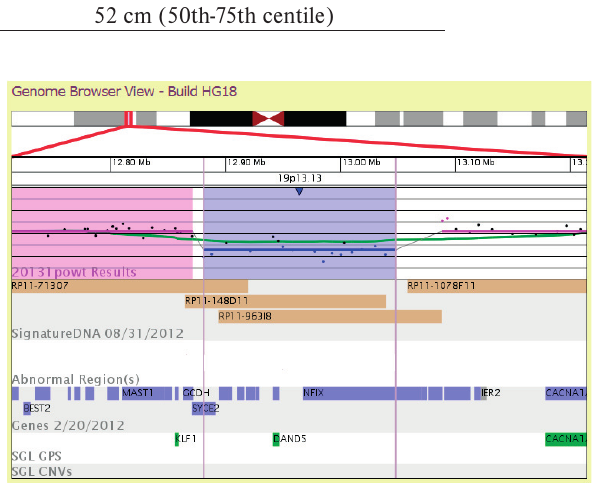
Fig. 3. NimbleGen CGX-3 v1.0 3-plex array result – deletion of 19p13.13 region (with genomic coordinates chr19:12881047- 13048119; hg